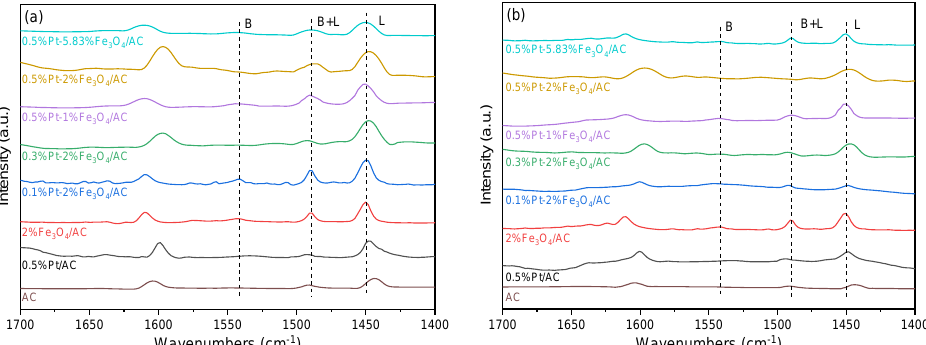
Figure 5. Py-FTIR spectra of different catalysts after pyridine adsorption at 50 °C and desorption at 150 °C ( a ) and 250 °C ( b ).